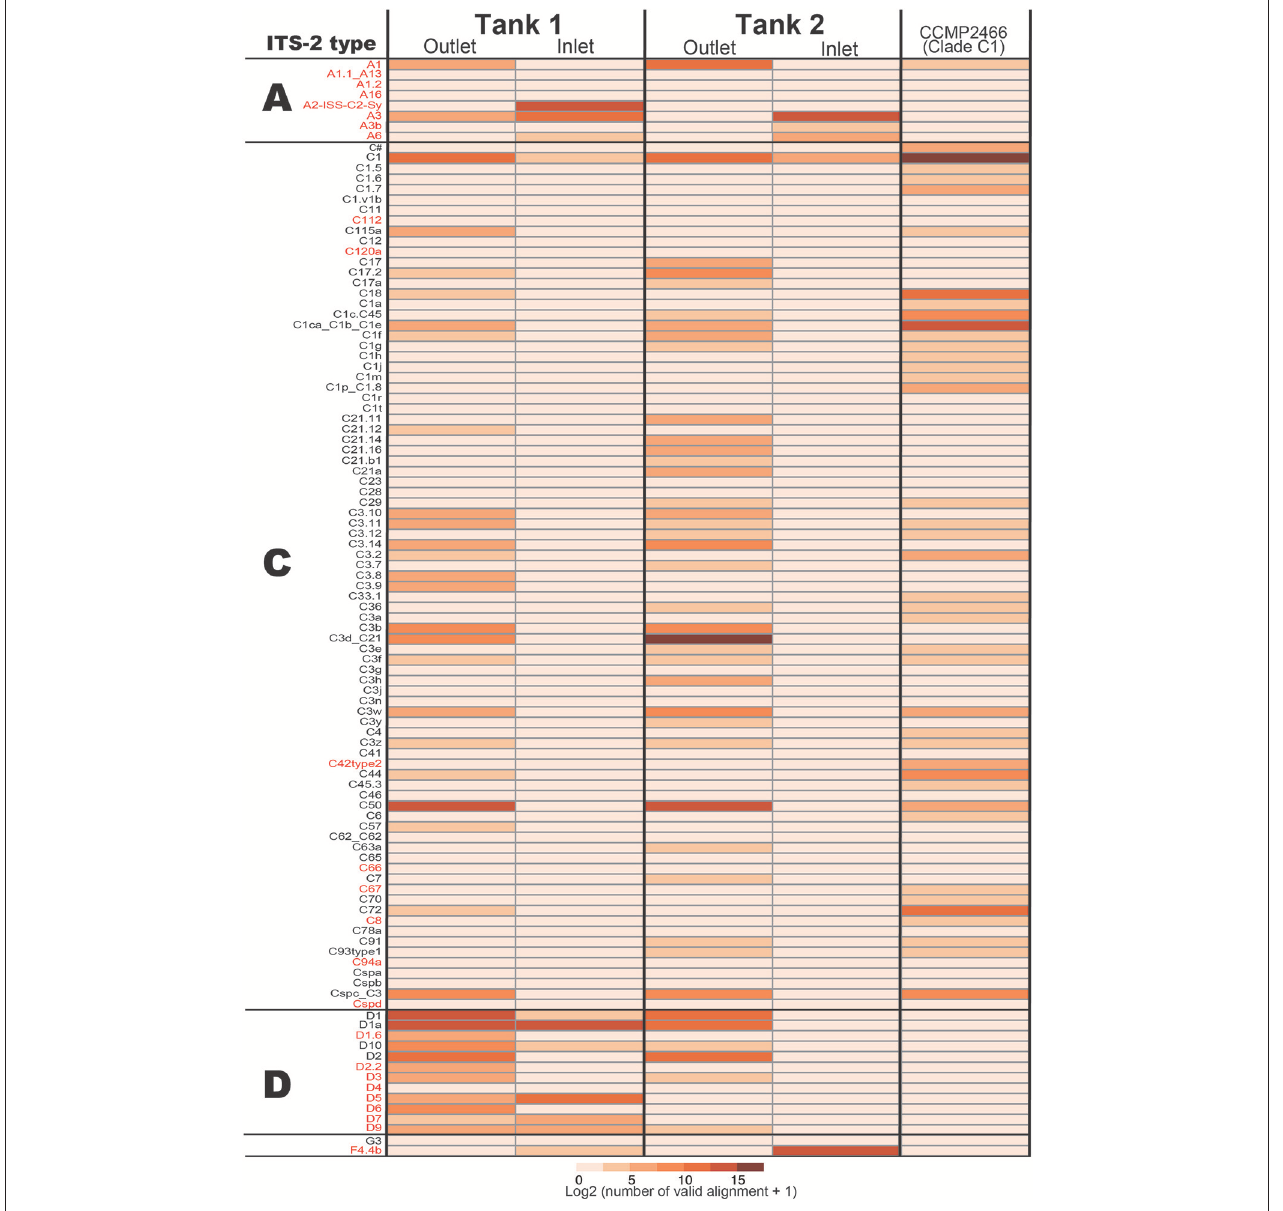
FIGURE 4 | The number of Symbiodinium ITS-2 types detected by eDNA PCR amplicon sequencing and CCMP2466 as a positive control. ITS-2 types that share the same GeoSymbio names in the database were summed (raw numbers of valid alignments are available in Supplementary Materials). ITS-2 types belonging to the same clade (A, C, or D) are separated and ITS-2 types in red indicate that these were not detected in the Acropora colonies used in this study ( Figure 2